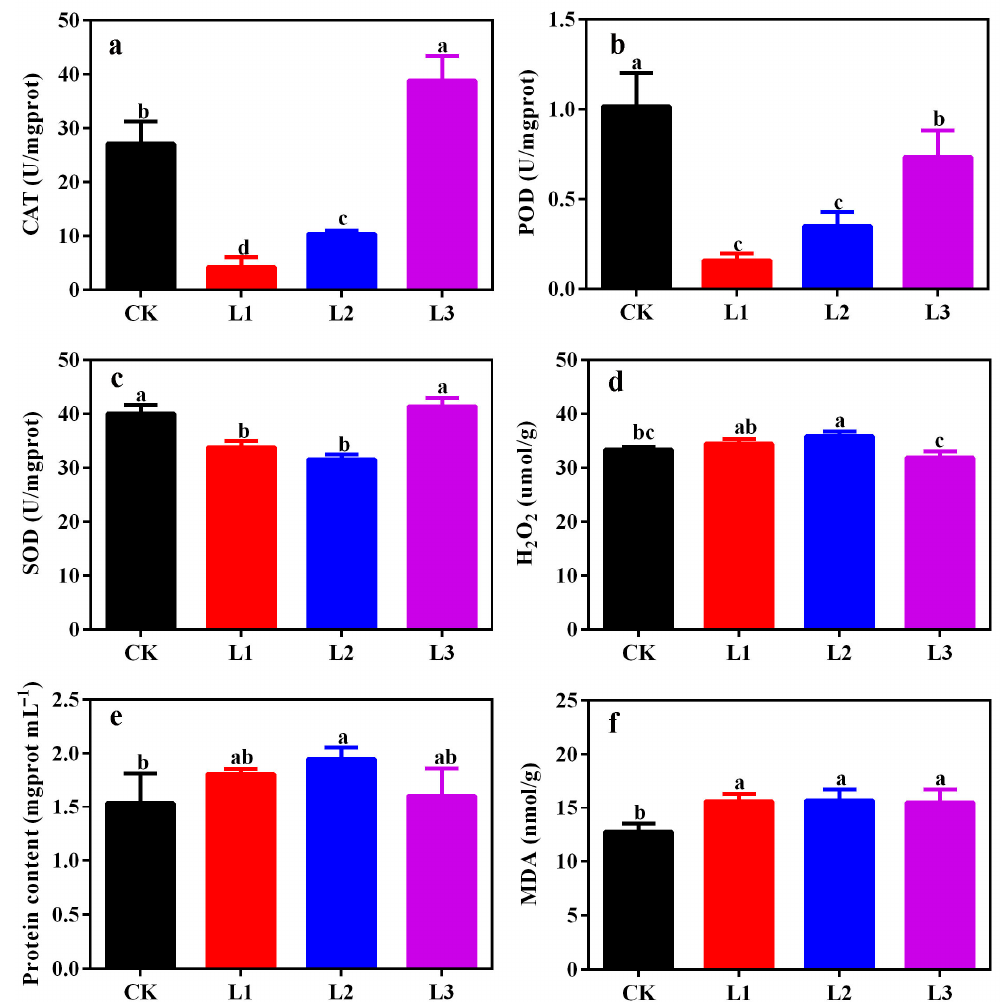
Figure 9. Changes in the activity of antioxidant enzymes CAT ( a ), POD ( b ), and SOD ( c ) and levels of H 2 O 2 ( d ) protein content ( e ) and MDA ( f ) in ‘Misty’ leaves under different light qualities in a plant factory with artificial lighting. Notes: CK, white LED light; L1, red spectrum, L2, blue spectrum, L3, 60% red + 40% blue spectrum. All data are mean ± standard deviation (SD) of three replicates. Different letters indicate significance at p ≤ 0.05 based on Duncan’s multiple range tests. The bar indicates the standard deviation.